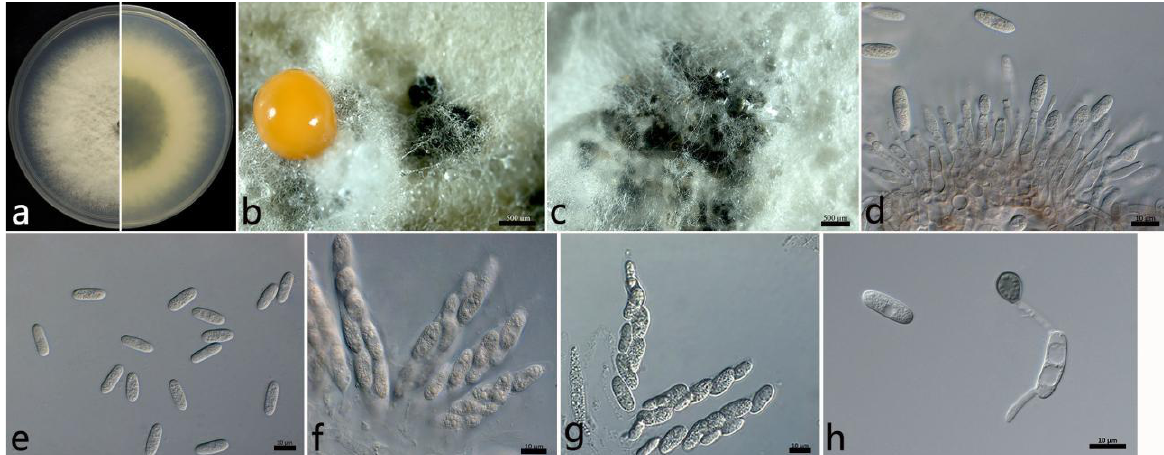
Figure 3. The morphological characteristics of Colletotrichum aenigma (WH2-9) isolated from anthrac- nose leaves of Salix babylonica . ( a ) Colony on PDA from above and below (5 d). ( b ) Conidial mass and ascomata (on PDA). ( c ) Ascomata (on PDA). ( d ) Conidiophores, conidiogenous cells, and conidia. ( e ) Conidia. ( f ) Asci and ascospores. ( g ) Ascospores. ( h ) Conidia and appressorium. Scale bars: ( b , c ) = 500 µm; ( d – h ) = 10 µm.